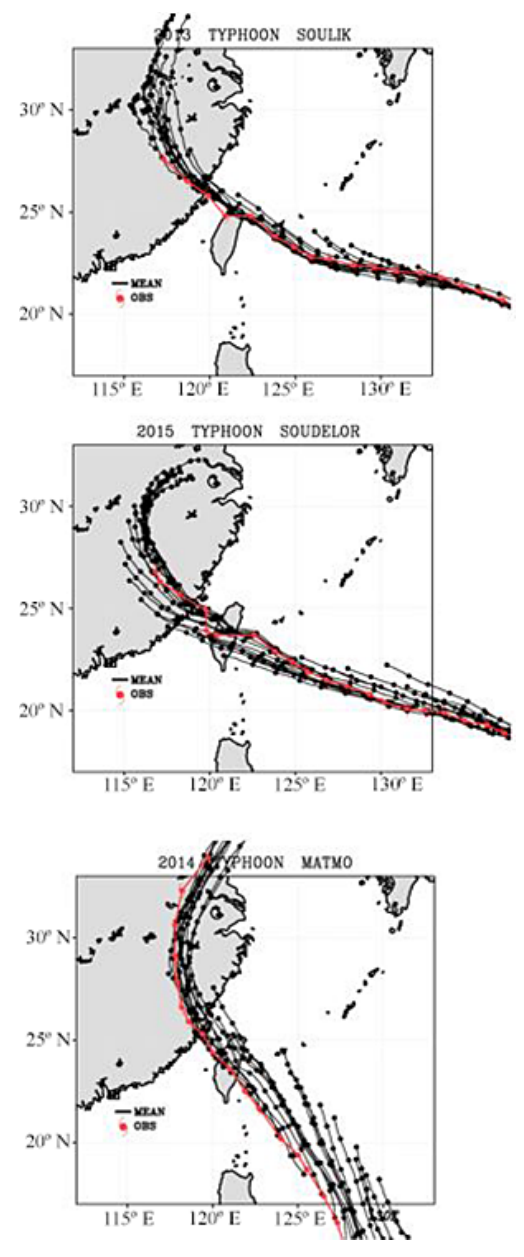
Figure 6. Comparisons of forecasted and observed typhoon tracks for Soulik (top), Soudelor (middle), and Matmo (bottom): black lines are TAPEX’s ensemble mean forecasted tracks and each black line’s forecasting length is